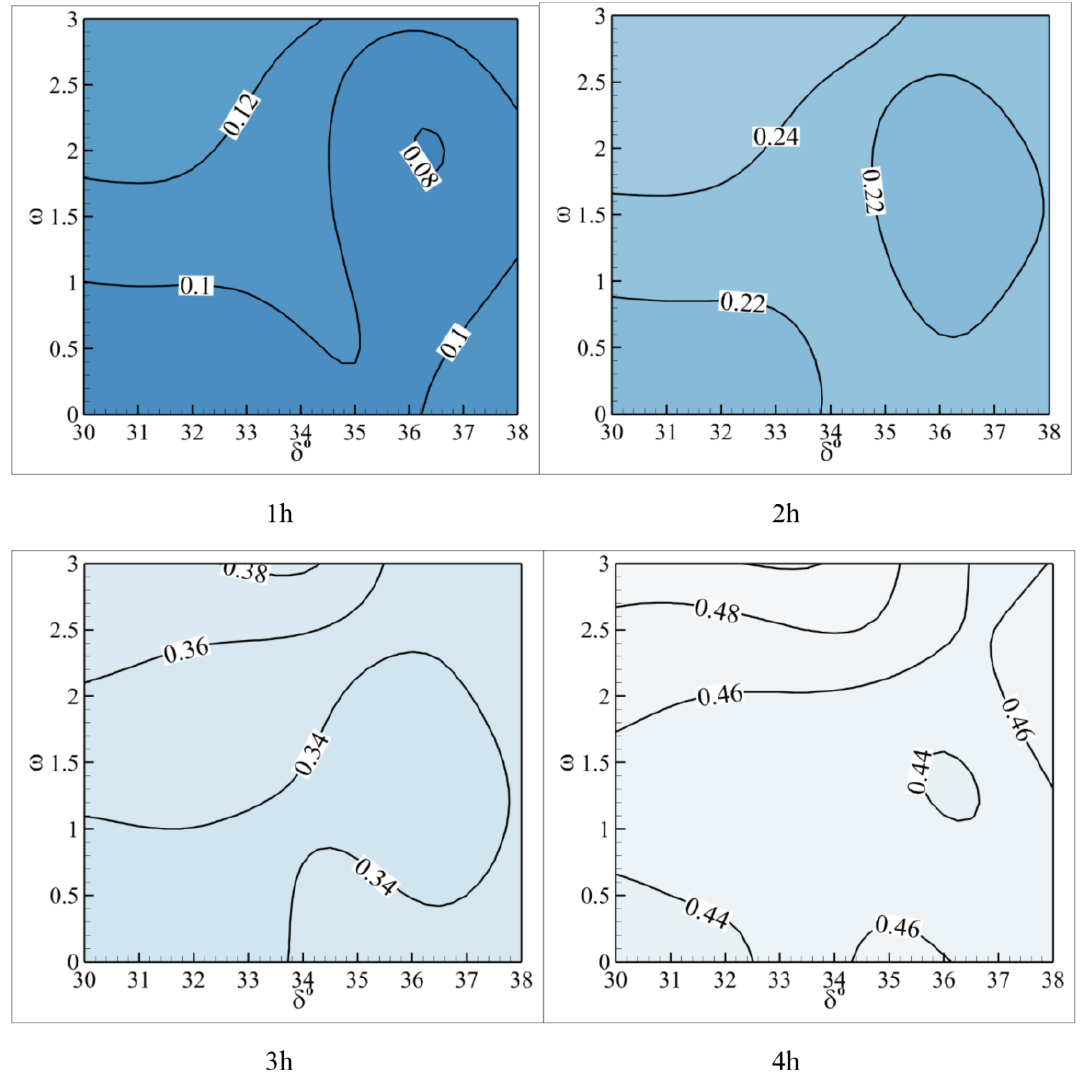
Figure 16. Contours of MVF for each melting hour as a function of angle ( δ ) and nanoparticles fraction ( ω ).